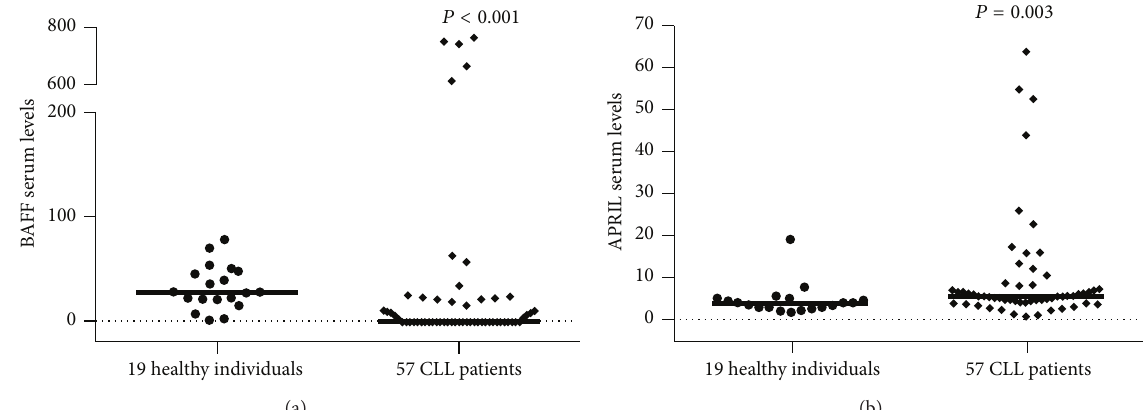
Figure 3: (a) BAFF levels in CLL patients and healthy controls. (b) APRIL serum levels in CLL patients and controls. Lines indicate median values. The significant 𝑃 values refer to Mann-Whitney 𝑈